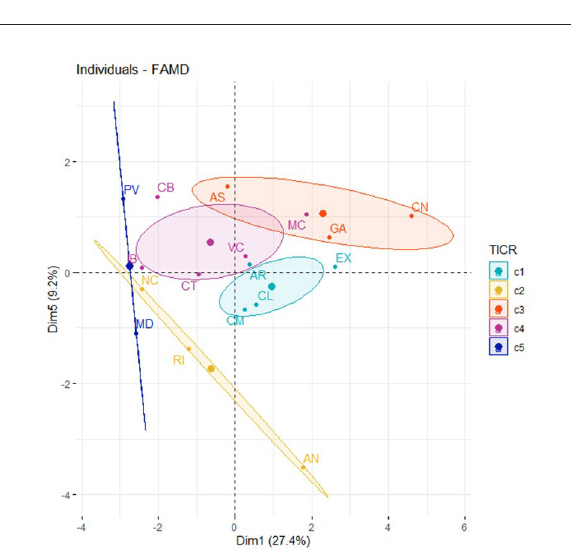
FIGURE7 Factor map of the ACS. Dimension 1, Dimension 3, and TICR.